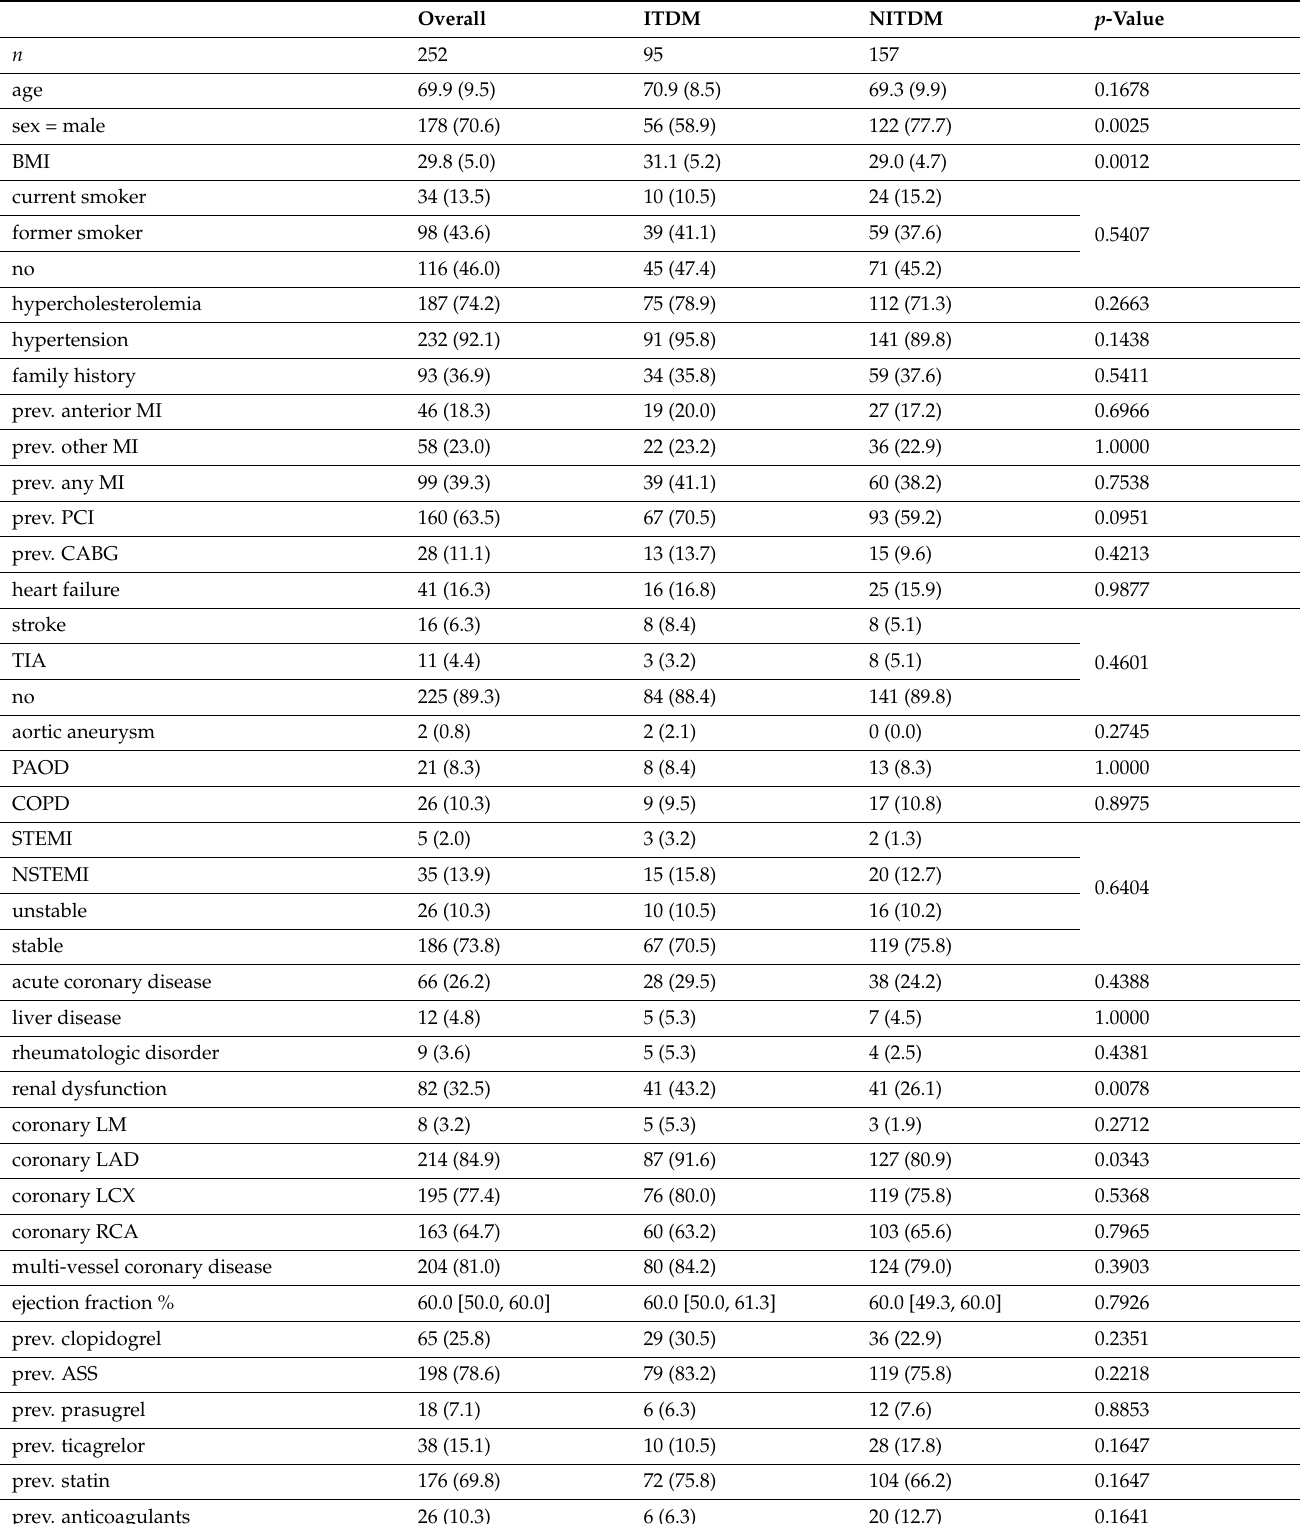
Table 1. Baseline